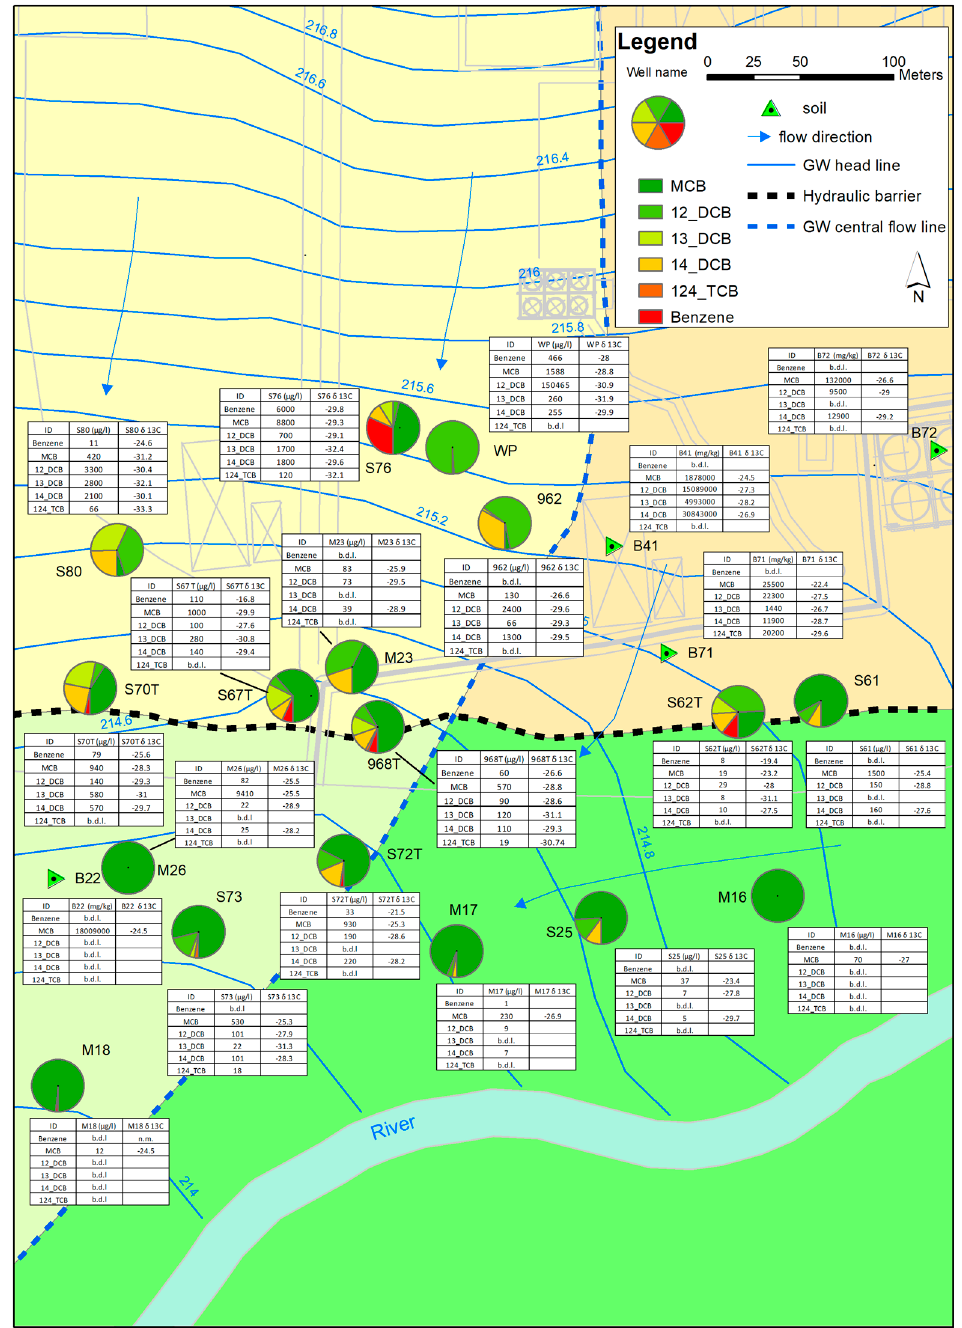
Figure 2. Map of locations used for sampling showing total chlorobenzene concentrations ( µ g L − 1 ), δ 13 Csum ( ‰ ) and molar fraction distributions along the groundwater flow system.